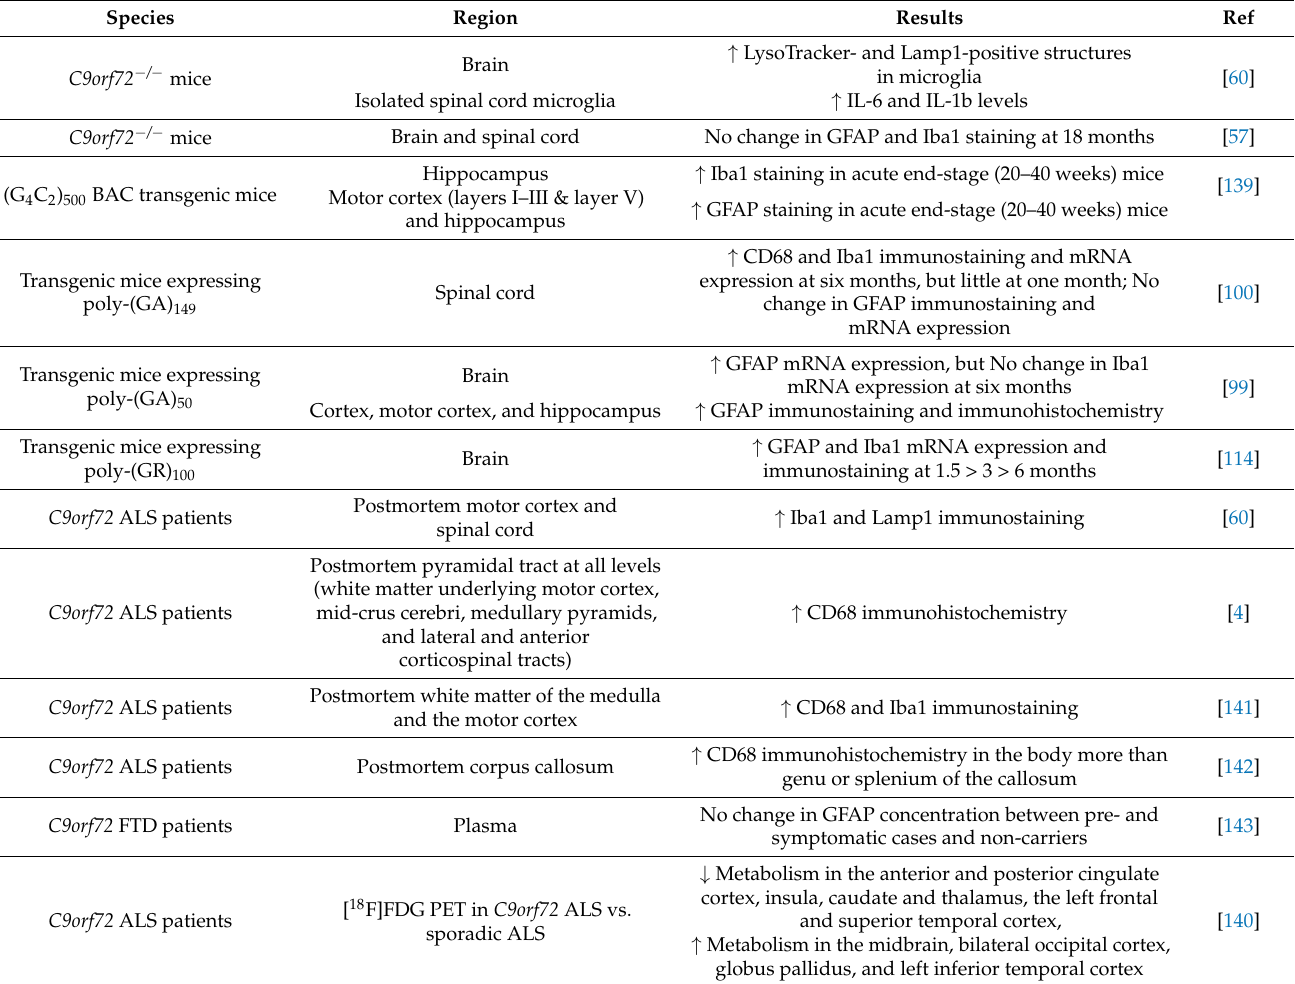
Table 2. Evidence of gliosis in C9orf72